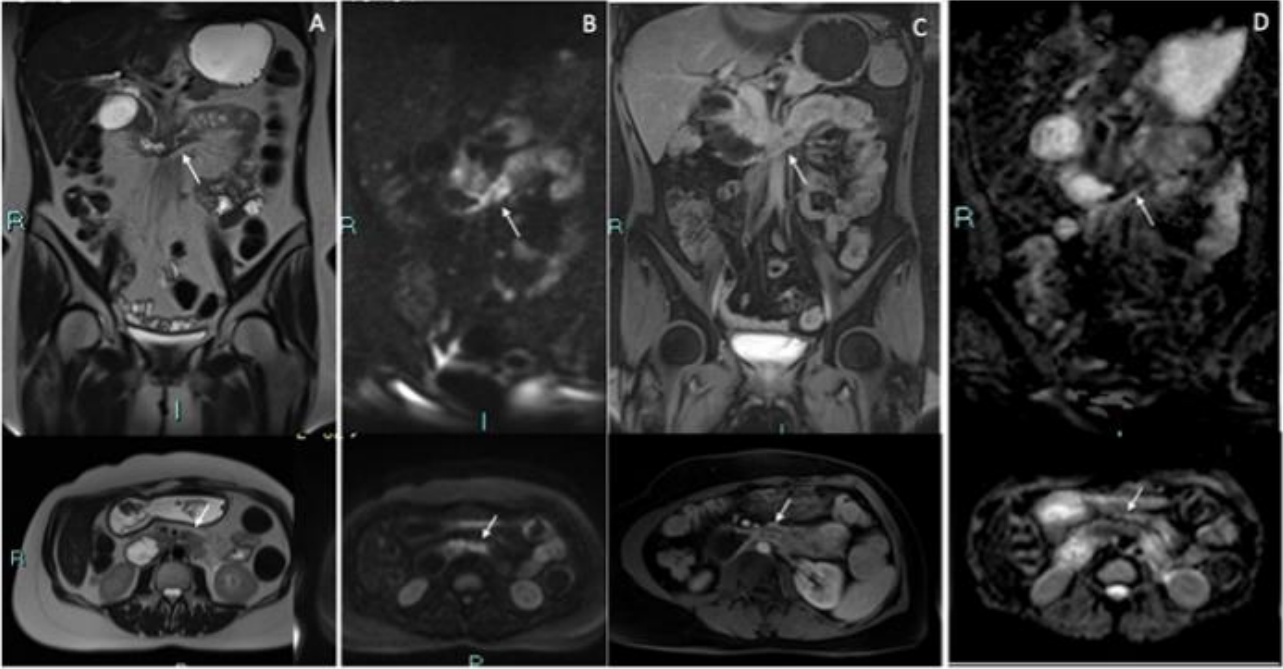
Figure 1. Pre-operative MRI (Magnetic Resonance Imaging) examination was per Figure 2. w-haste images and axial T2w-haste images showed severe stenosis of the third duodenal portion. ( B , C ) DWI (Diffusion Weighted Imaging) ( A ) and ADC (Apparent Diffusion Coefficient) ( B ) sequences coronal and axial images showed an evident restriction of diffusivity due to the marked increase in cellularity in the neoplastic tissue ( D ). Coronal and axial T1 and post-contrast (gadolinium) images showed marked contrast impregnation of the wall. There was no significant biliary dilatation.